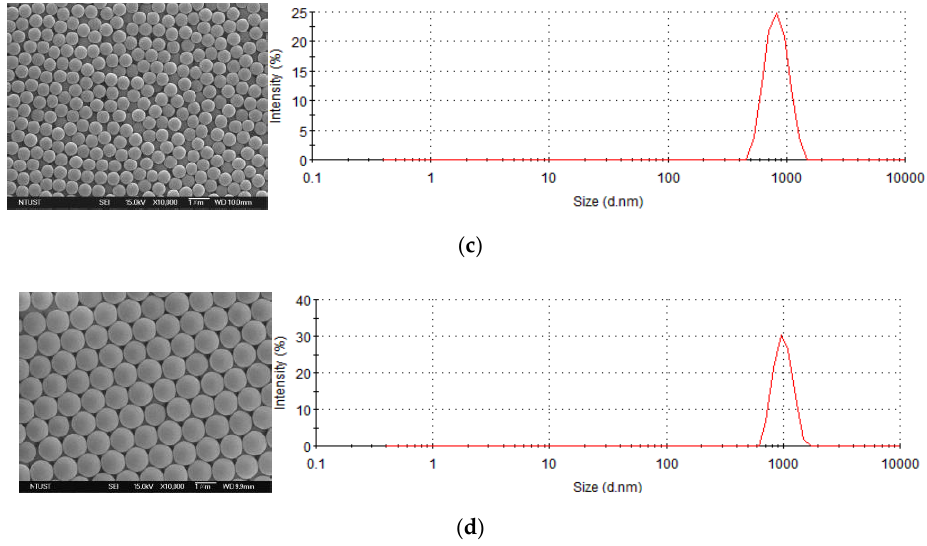
Figure 2. SEM image and dynamic light scattering (DLS) data of ( a ) PN1, ( b ) PN2, ( c ) PN3, and ( d ) PN4.